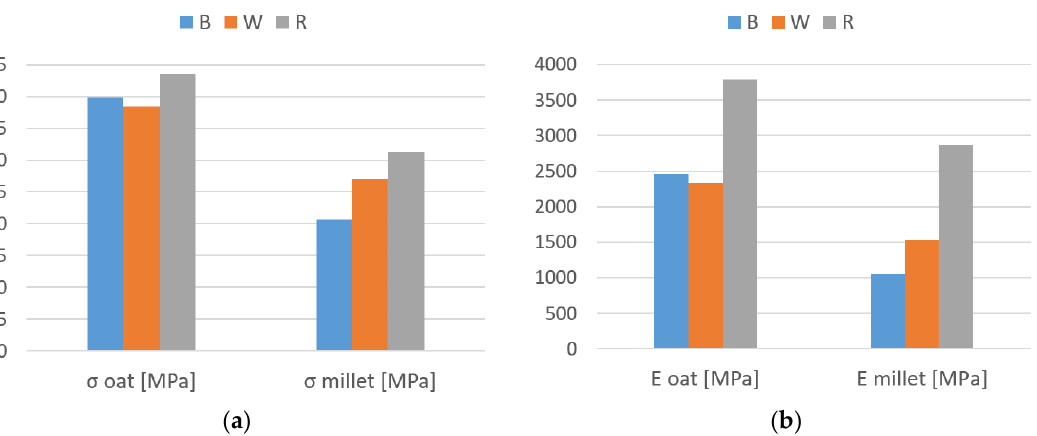
Figure 4. Test results of ( a ) bending strength and ( b ) modulus of elasticity of oat and millet husk- reinforced composites after exposure to Coniophora puteana and manual mycelium removal with a soft brush (B) and with water under pressure (W). Test results of reference specimens in initial state (R) have been also presented. The results are expressed in MPa.